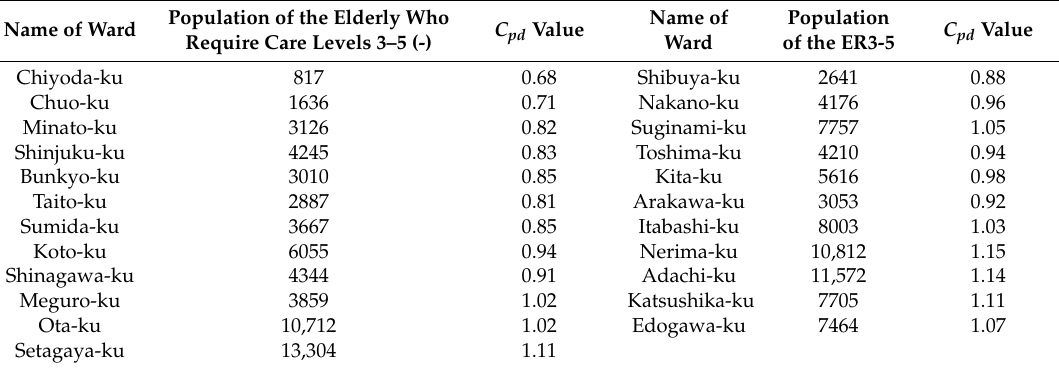
Table 2. C pd value at each